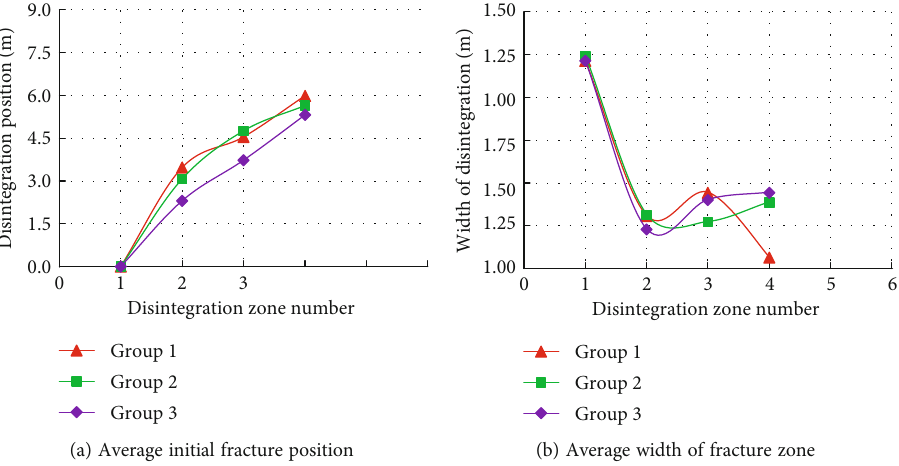
Figure 19: Distribution diagram of zonal fracture under con fi ning pressure in 213 fl oor roadway of Qujiang Coal Mine.